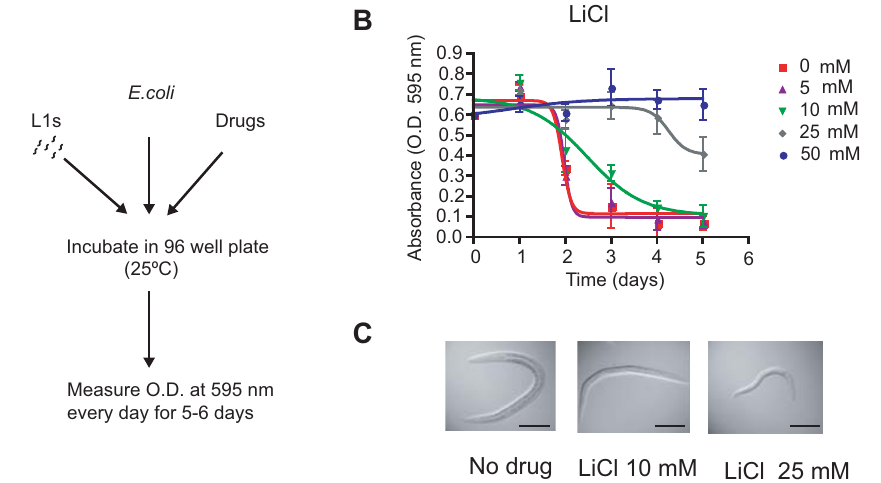
Figure 1. Concentration of compounds for testing was assessed using a food clearance assay. (A) Flow diagram of the food clearance assay. 20 newly hatched L1 animals were incubated at 25 u C in E. coli at a final OD (A 595 ) of 0.6 in 96 well microtiter plate wells containing varying drug concentrations. The OD of the microtiter plate was measured daily for 5 days. (B) The OD of E. coli is reported daily for each concentration of LiCl. The mean OD is calculated for each day from triplicate samples and plotted over time. Error bars represent SEM. Food clearance assays were also performed on trichostatin A and mithramycin, ( Figure S1 ). (C) Animals treated with no drug and indicated LiCl concentrations. Animals treated with 50 mM or 100 mM LiCl are alive but concentrations above 100 mM LiCl cause death (data not shown). Scale bar is approximately 75 m